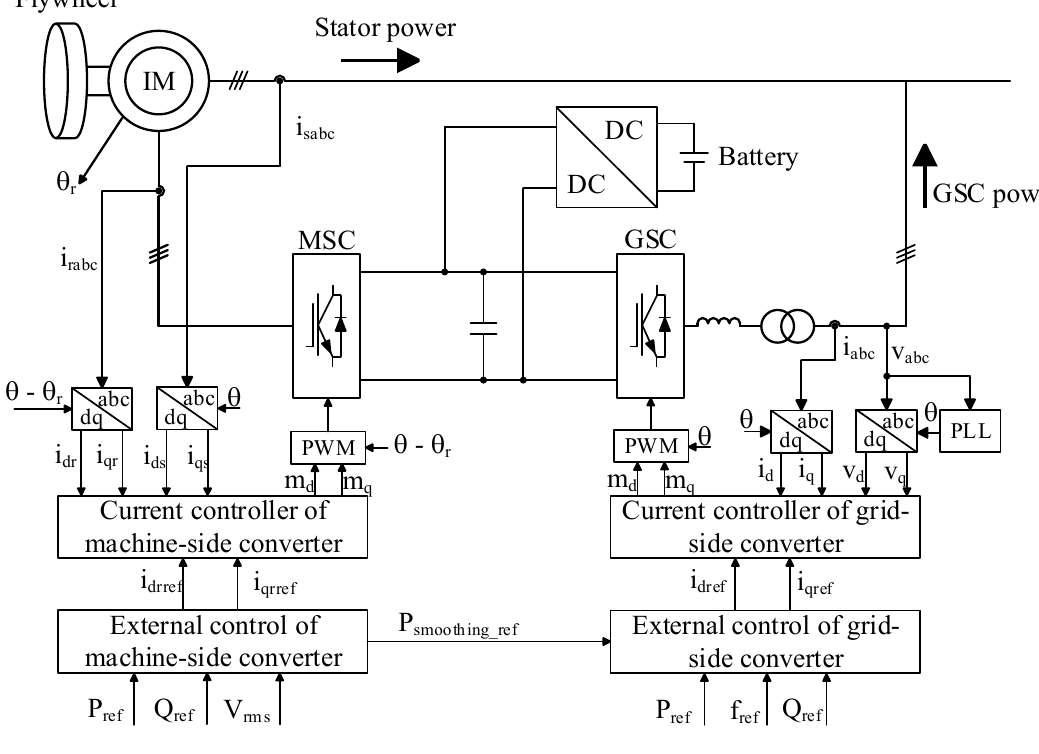
Figure 2. Control systems of the proposed FES